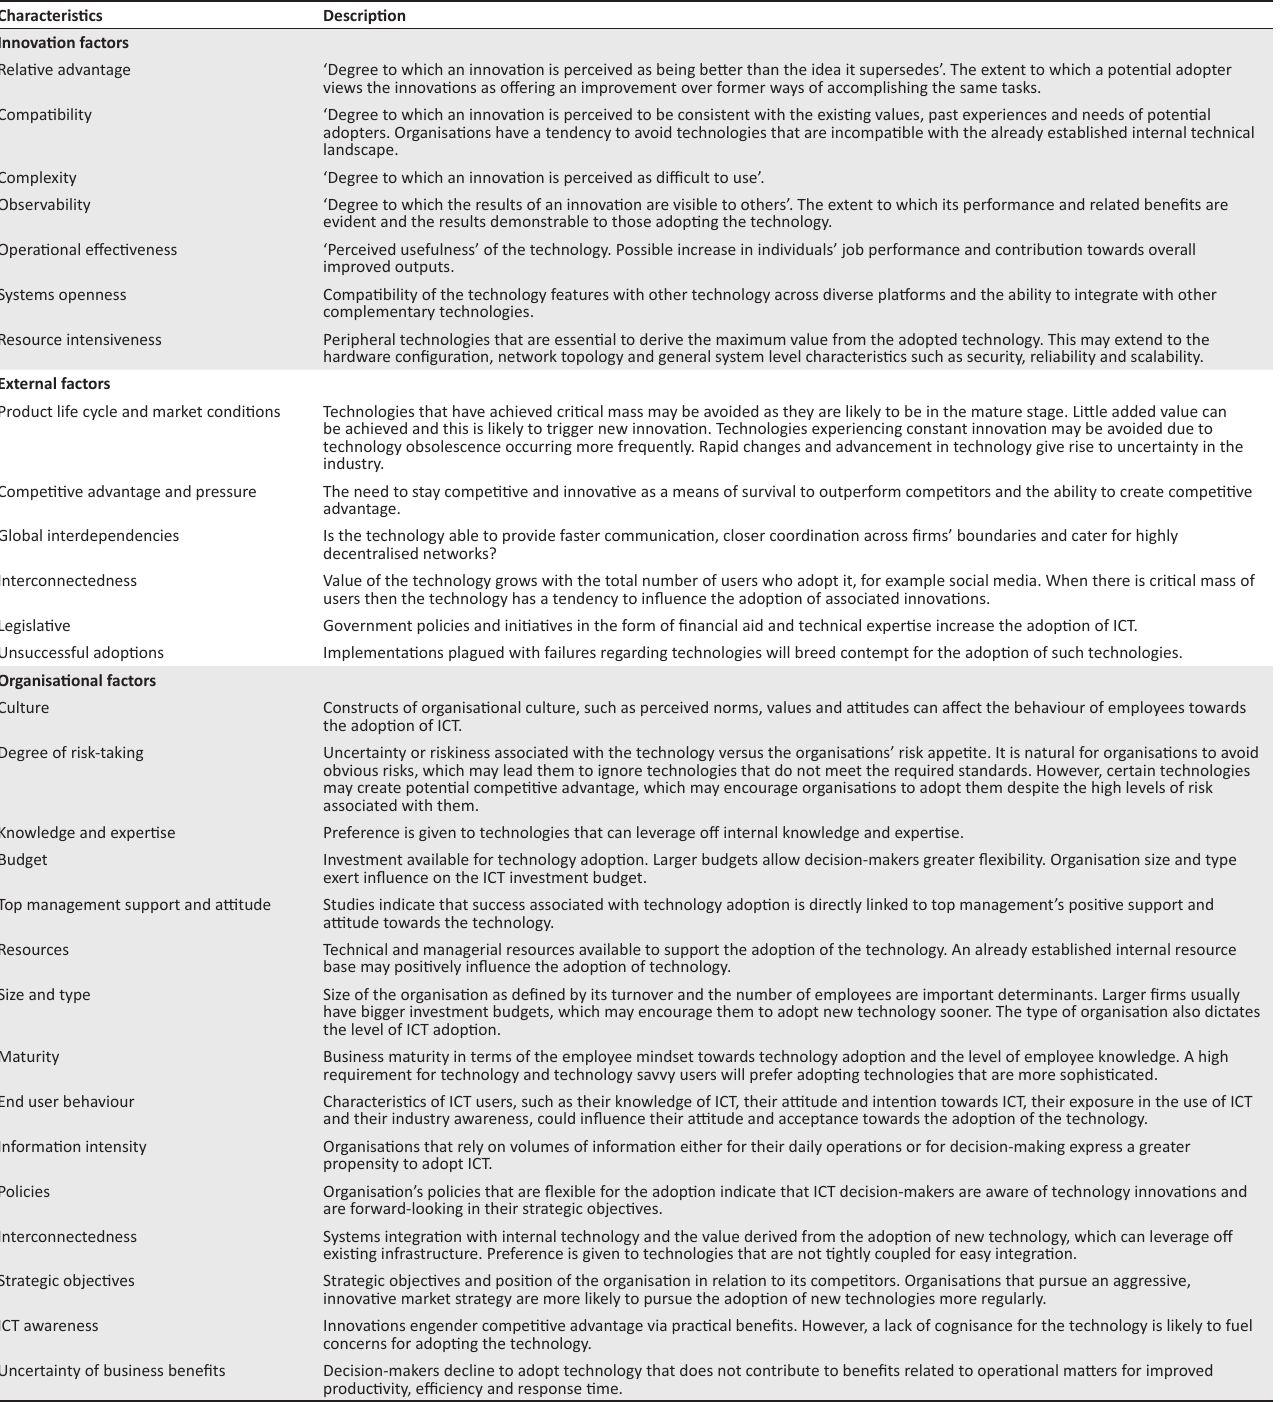
TABLE 3: Characteristics of factors related to ICT